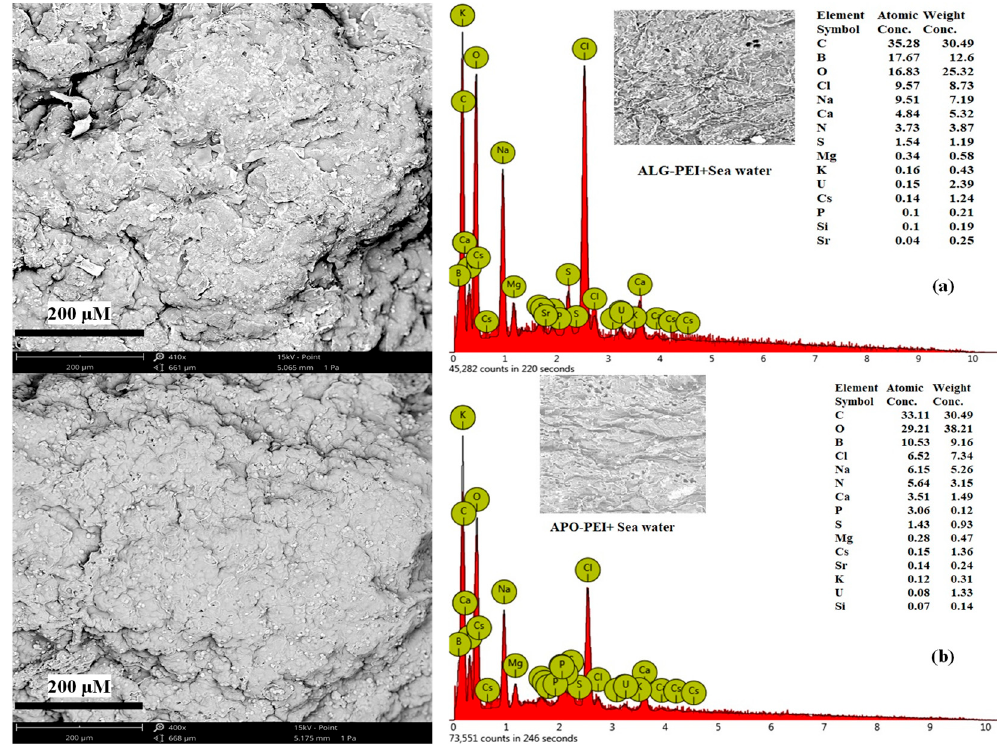
Figure A21. Time evolution of sorption efficiency for major elements ( a ) and trace elements ( b ) using ALG-PEI (empty symbols) and APO-PEI (filled symbols) sorbents (initial concentrations see Table